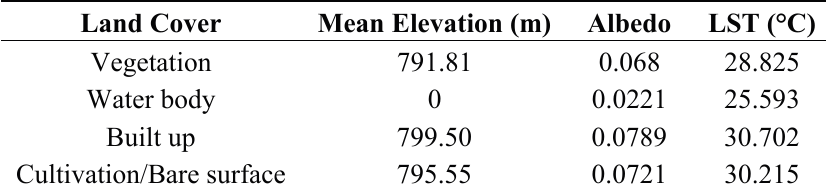
Figure 7. Topography in the three regions. Table 5. Mean elevation, mean albedo and mean LST across land cover types in Kafachan in 1986.